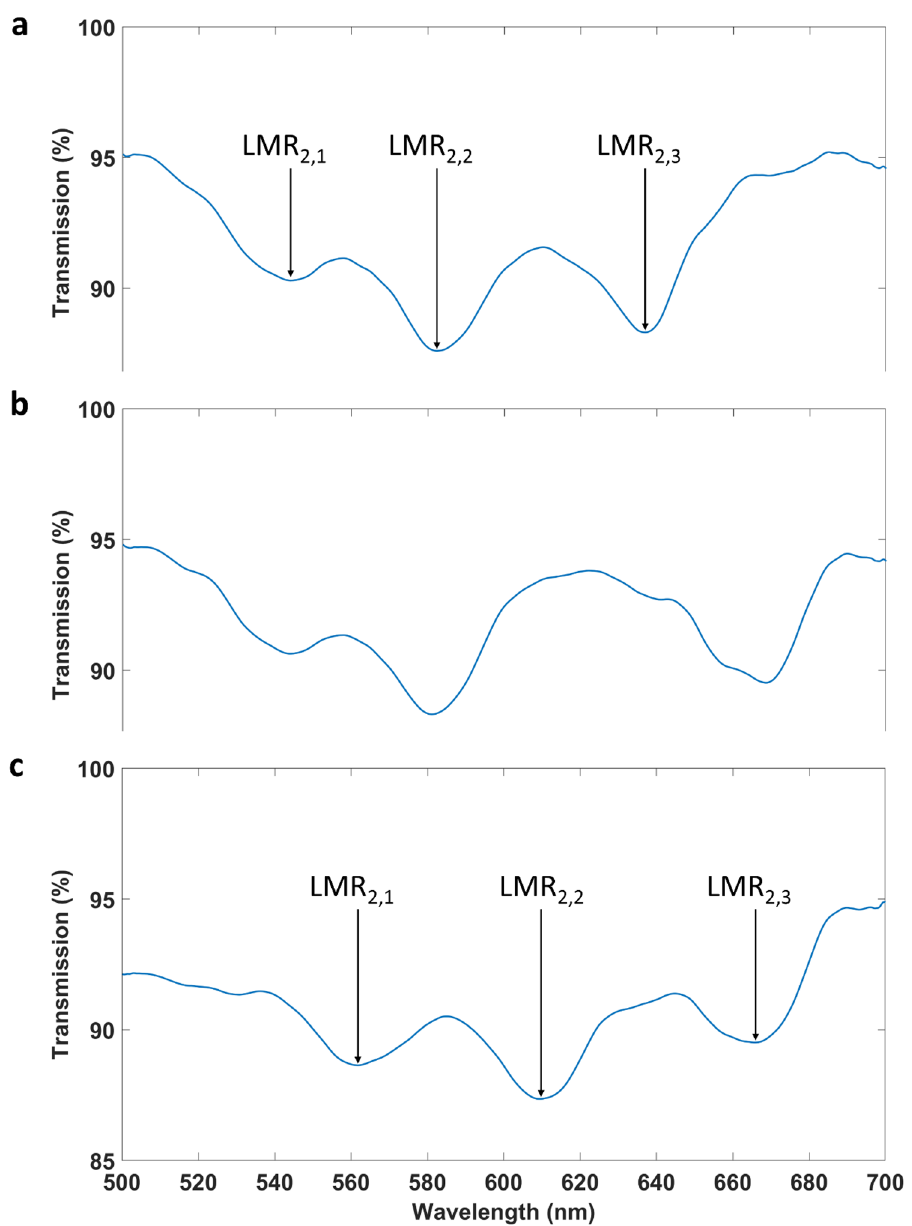
Figure 6. LMRs generated with device 2 (angle of deposition 30º) for different surrounding medium refractive indices. (a) LMRs when the all the three regions are surrounded by air (RI = 1); (b) LMRs when the all the regions are surrounded by air except for region 3, which is surrounded by water; (c) LMRs when the all the three regions are surrounded by water (RI =